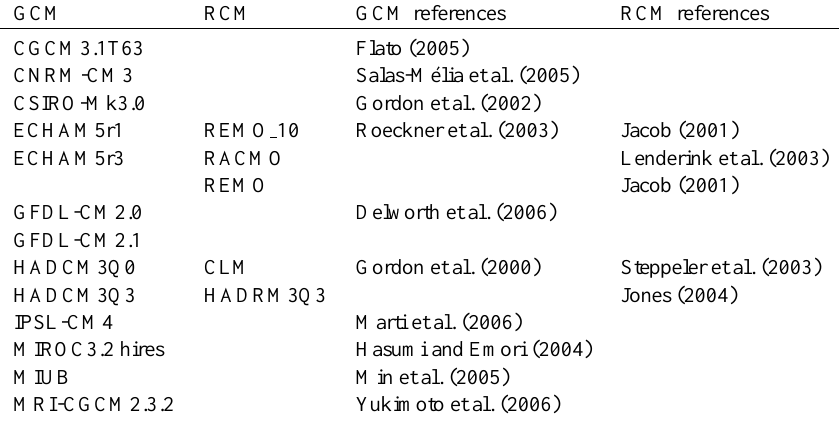
Table 1. GCM and RCM simulations used in this study. Note that two different transient simulations with the ECHAM5 model (r1 and r3, which refer to runs with different initial conditions) were used as RCM boundary conditions; two RCMs are forced by